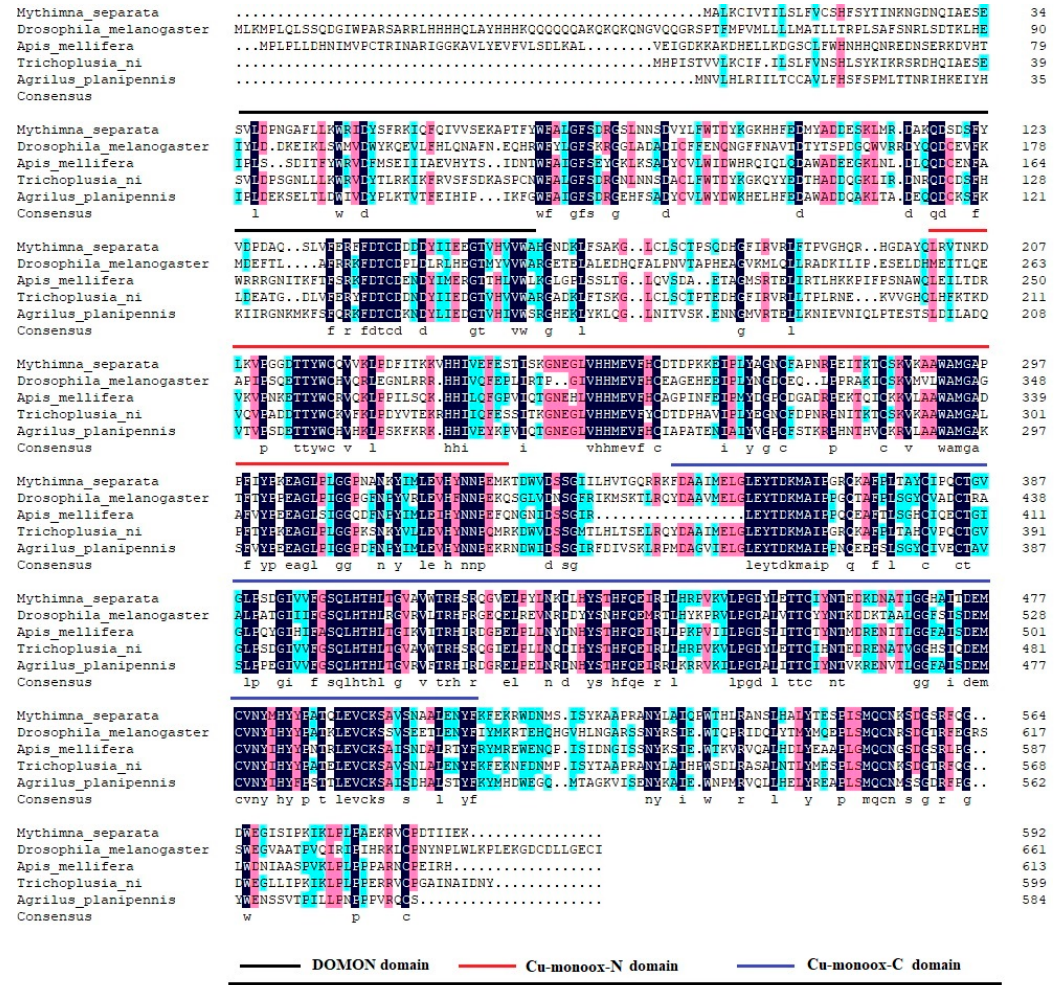
Figure 3. Multiple sequence alignment of tyramine β -hydroxylase ( MsT β h ) with other insect tyramine β -hydroxylases . The three different color lines represent the conserved domains, the black line is the DOMON domain, the red line the Cu-monox-N domain and the blue line Cu-monoox-C domain. A phylogenetic tree was constructed in MEGA 7.0 while using the amino acid sequences of tyramine β -hydroxylases from 30 insect species and Caenorhabditis elegans tyramine β -hydroxylase was used as the out-group (Figure 4). The tree showed that the insect tyramine β -hydroxylases are distributed in four main clades that correspond to Hymenoptera tyramine β -hydroxylases on one branch, Coleoptera on another branch, Lepidoptera on the third one, and Diptera on the fourth one. The MsT β h that was clustered with TnT β h ( Trichoplusia ni , XP_026739132.1) and the 75% similarity was found in a BLASTP search of the National Center for Biotechnology Information databases.